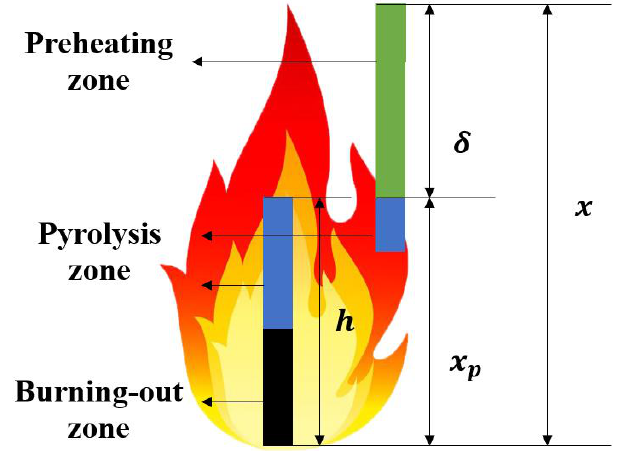
Figure 5. The physical model of vertical flame spread over discrete PMMA array.